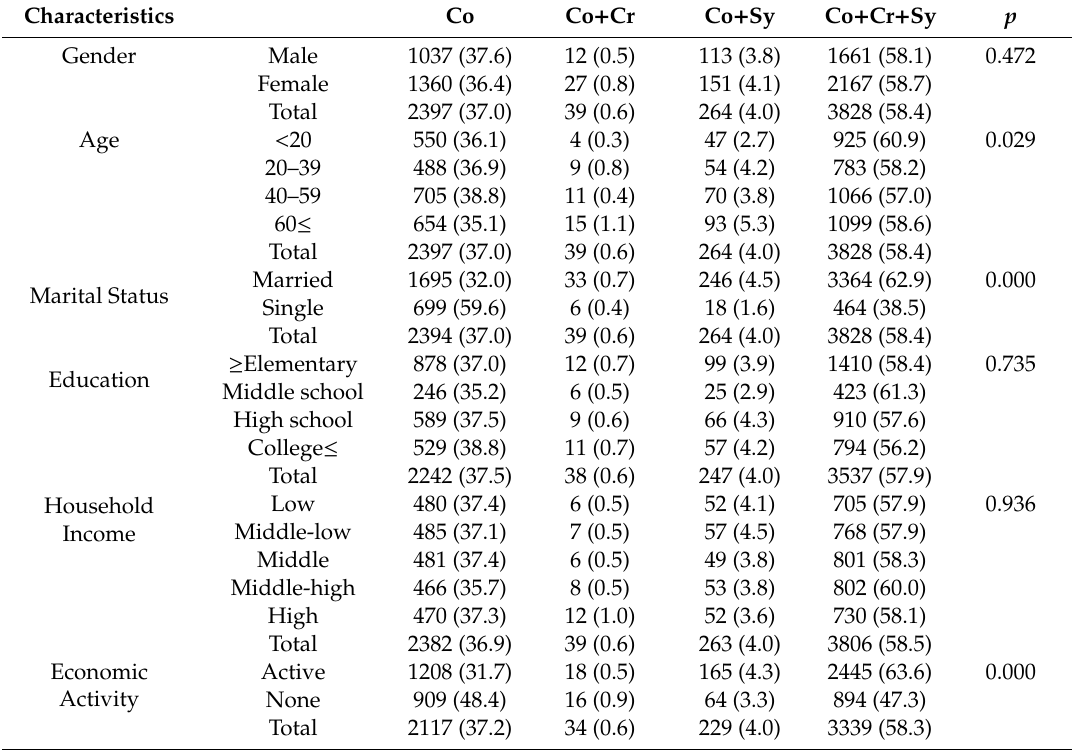
Table 2. Demographic Characteristics by Co ff ee Component (Unit: N